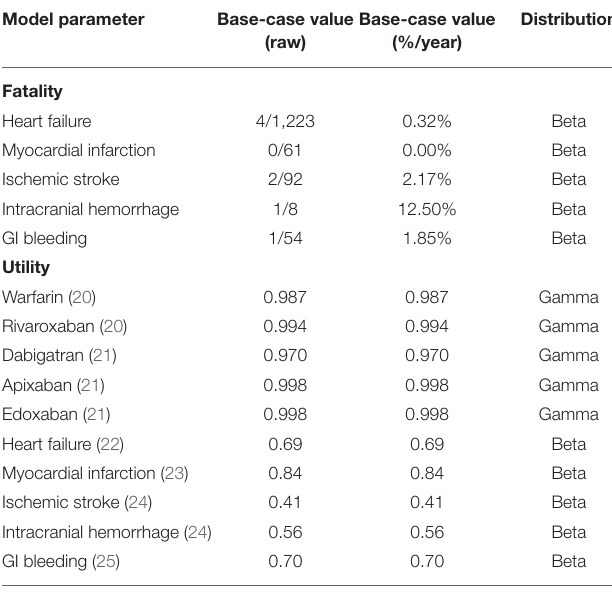
TABLE 5 | Base-case analysis result comparing warfarin and